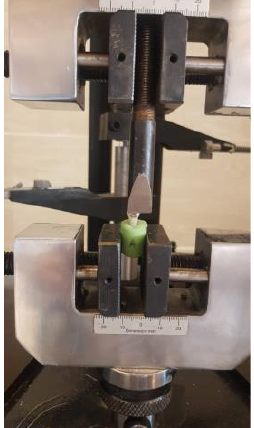
Figure 2. Positioning of a sample in the universal testing machine.